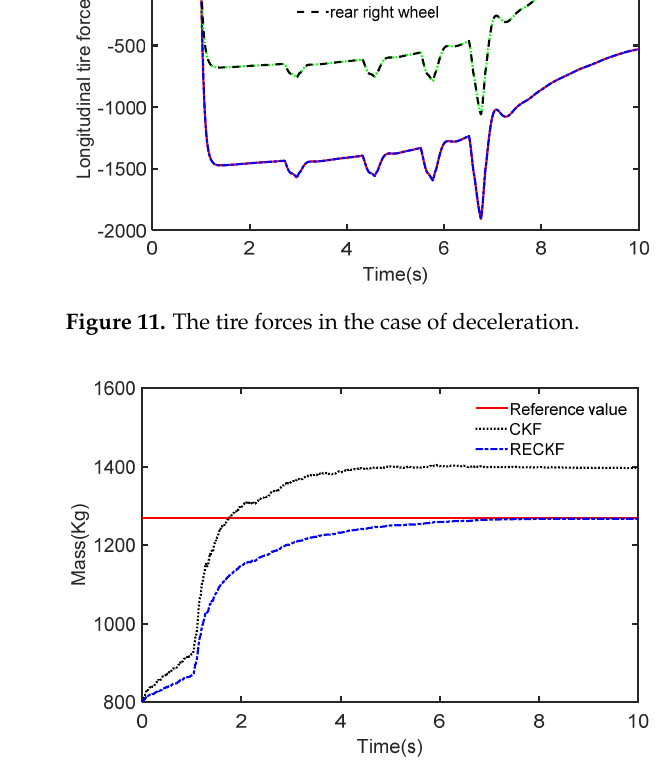
Figure 12. The estimated mass in the case of deceleration.